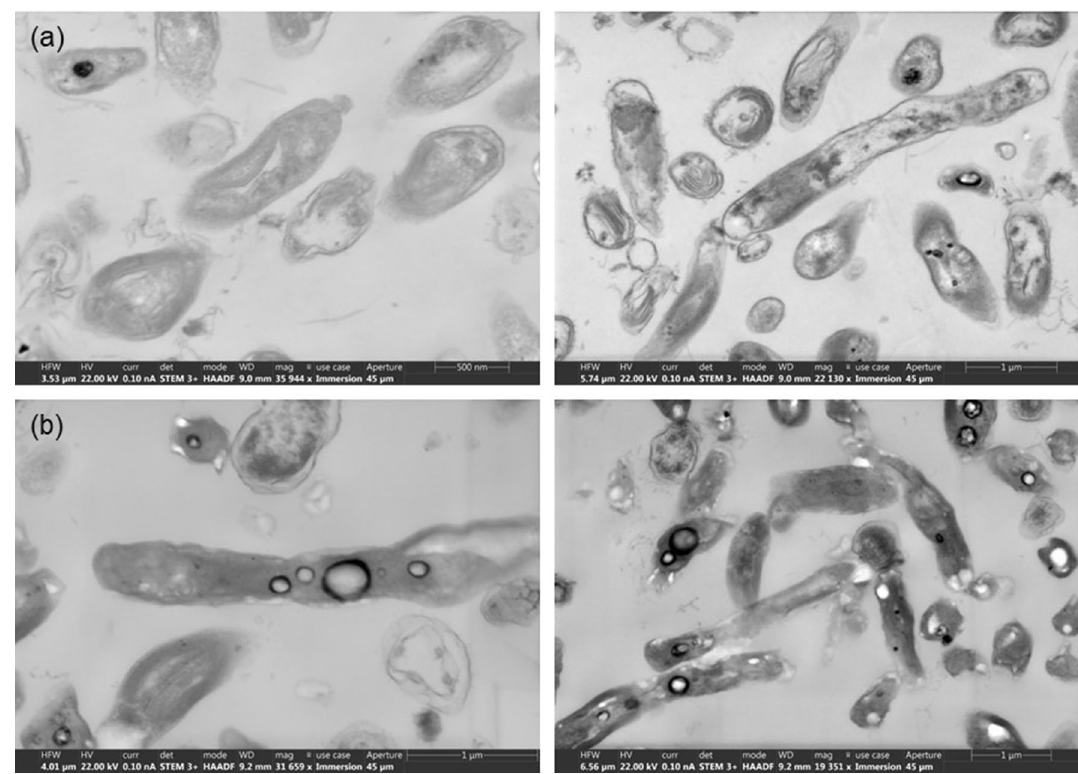
Fig. 5 Scanning transmission electron microscopy (STEM) images of R. palustris cells a before (at 0 h, after preculturing in Van Niels medium); and b after (at 456 h) being exposed to a diurnal illumination cycle — images taken by Stellenbosch University’s Central Analytical Facilities